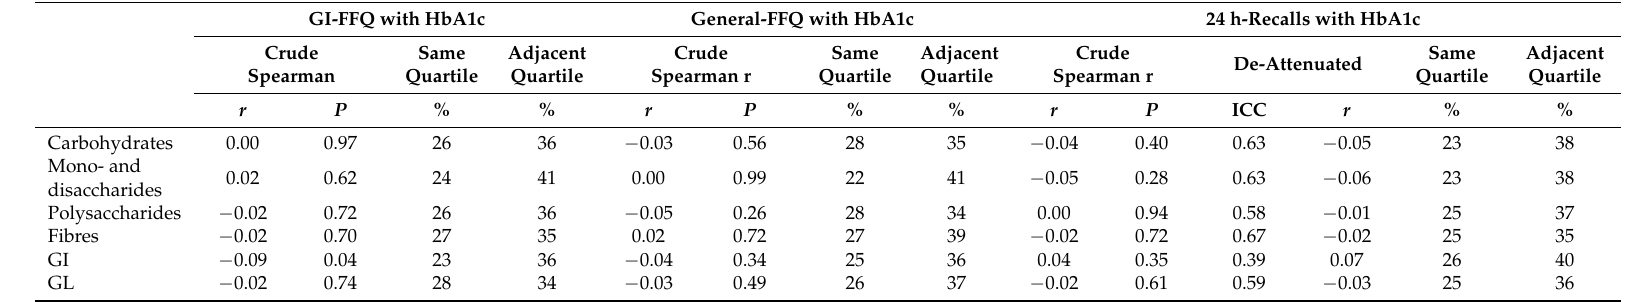
Table 4. Validation results of glycated haemoglobin (HbA1c) blood concentration with reported intakes of GI, GL in the 24 h-